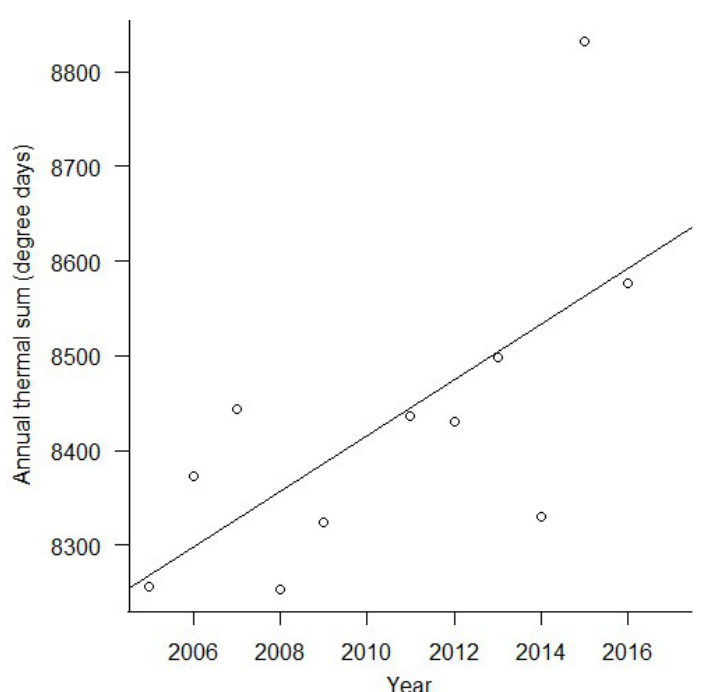
Figure 3. Thermal sum over the sampling period. Thermal sum increased over the course of our sample period ( R 2 = 0.39, F 1, 9 = 7.42, p = 0.023), shown here without 2010, which was an extremely influential outlier. The relationship is qualitatively similar, although not significant when 2010 is included (Figure S3).